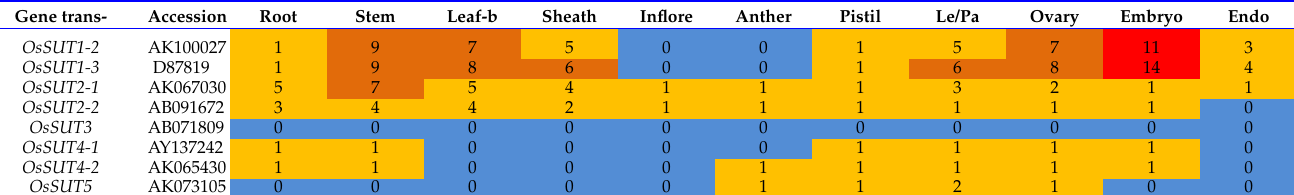
Table 2. Expression levels of SUT genes in various rice tissues based on gene chip data (https://ricexpro.dna.affrc.go.jp/, accessed on 22 August 2021).